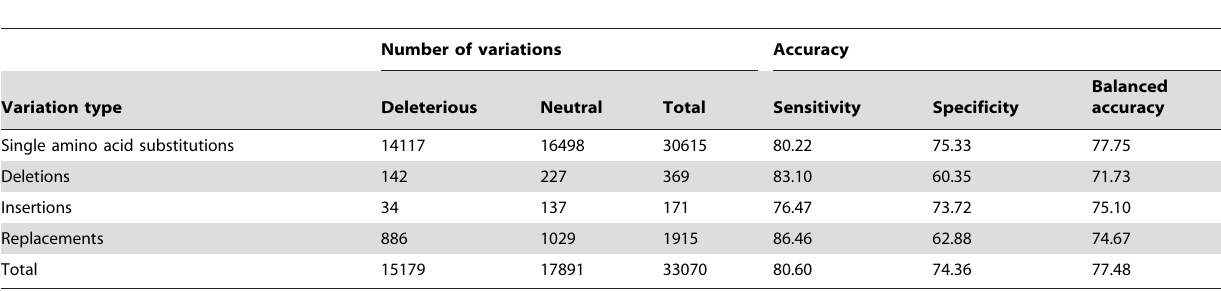
Table 3. Number of the UniProt non-human protein variations and prediction accuracy given a PROVEAN score threshold of 2 2.282.